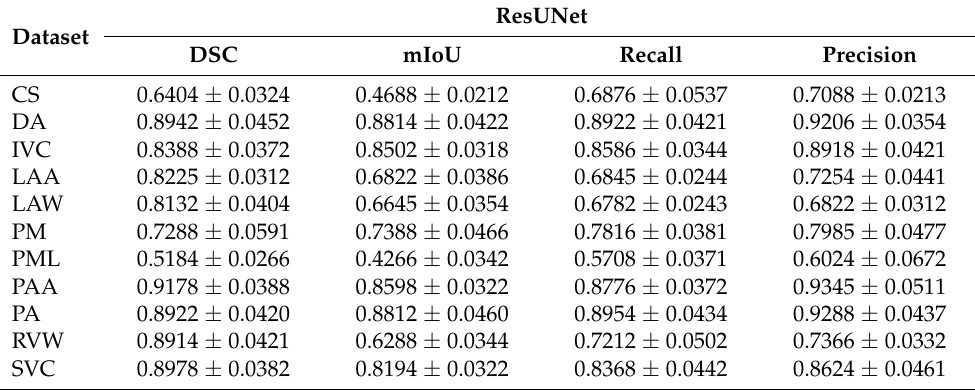
Table 4. Obtained segmentation results of different cardiovascular structures for ResUNet network